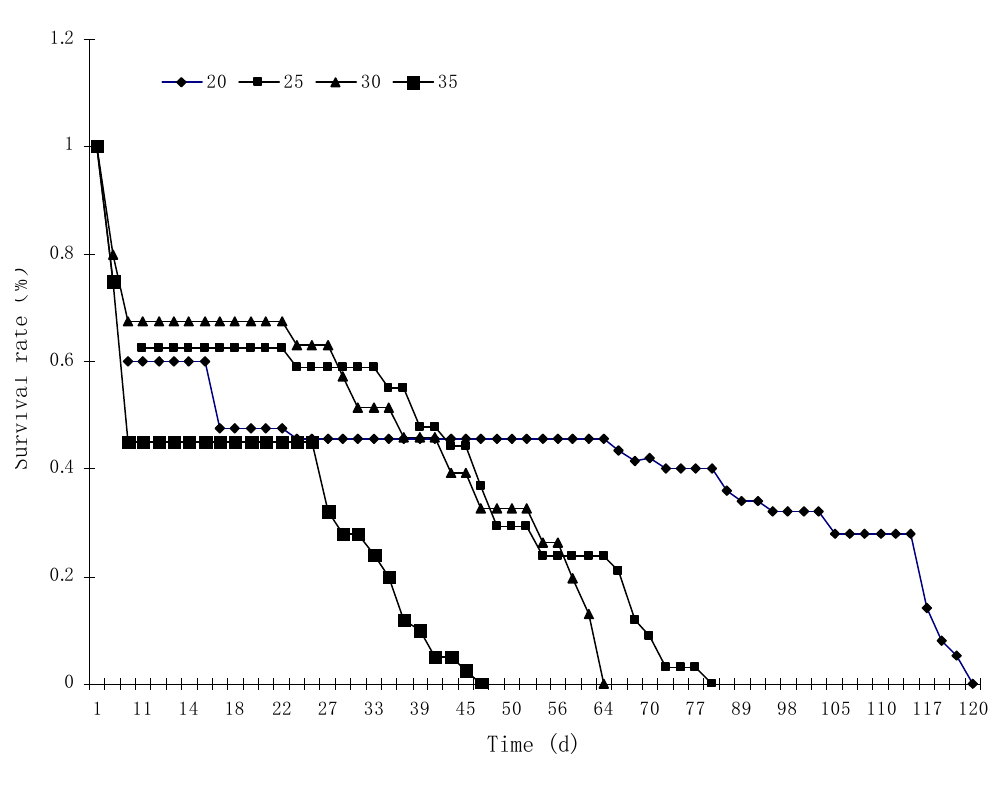
FIGURE 6 . Survival curves of P. dubia at different